Question: State the chart type depicted above.
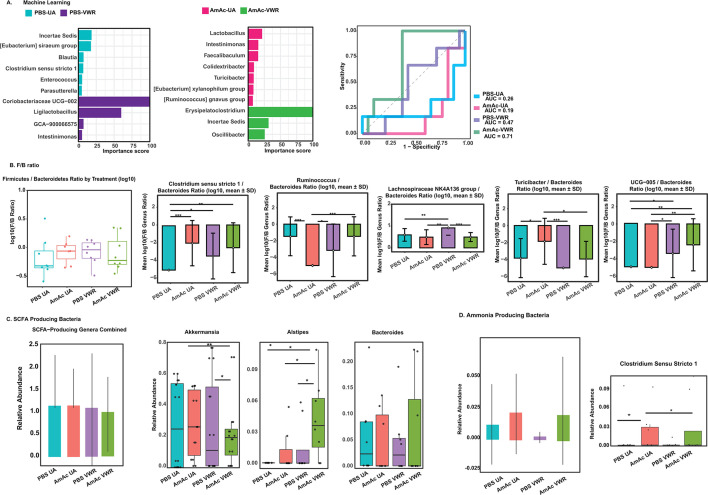
Answer: line